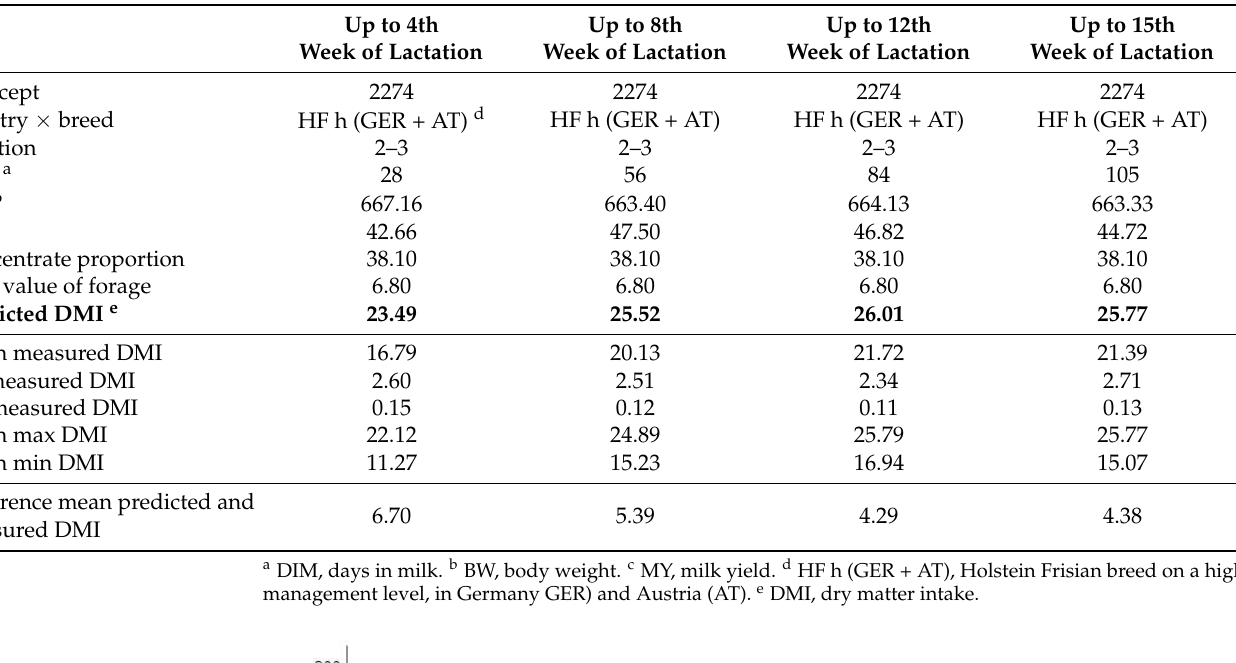
Figure 3. BCS data of dairy cows ( n = 28) between weeks 2 and 15 postpartum (p.p.). In each subfig- ure, the boxplots respectively highlight the median, upper, and lower quartiles of each week. Box whiskers extended to the most extreme nonoutlier data points were considered as outliers if they lay more than 1.5 times the interquartile range from the edge of the box. Small circles = outliers (1.5 × interquartile range (IQR)); asterisks = extreme values (3 × IQR). BCS changes between two weeks are shown in Figure 4.